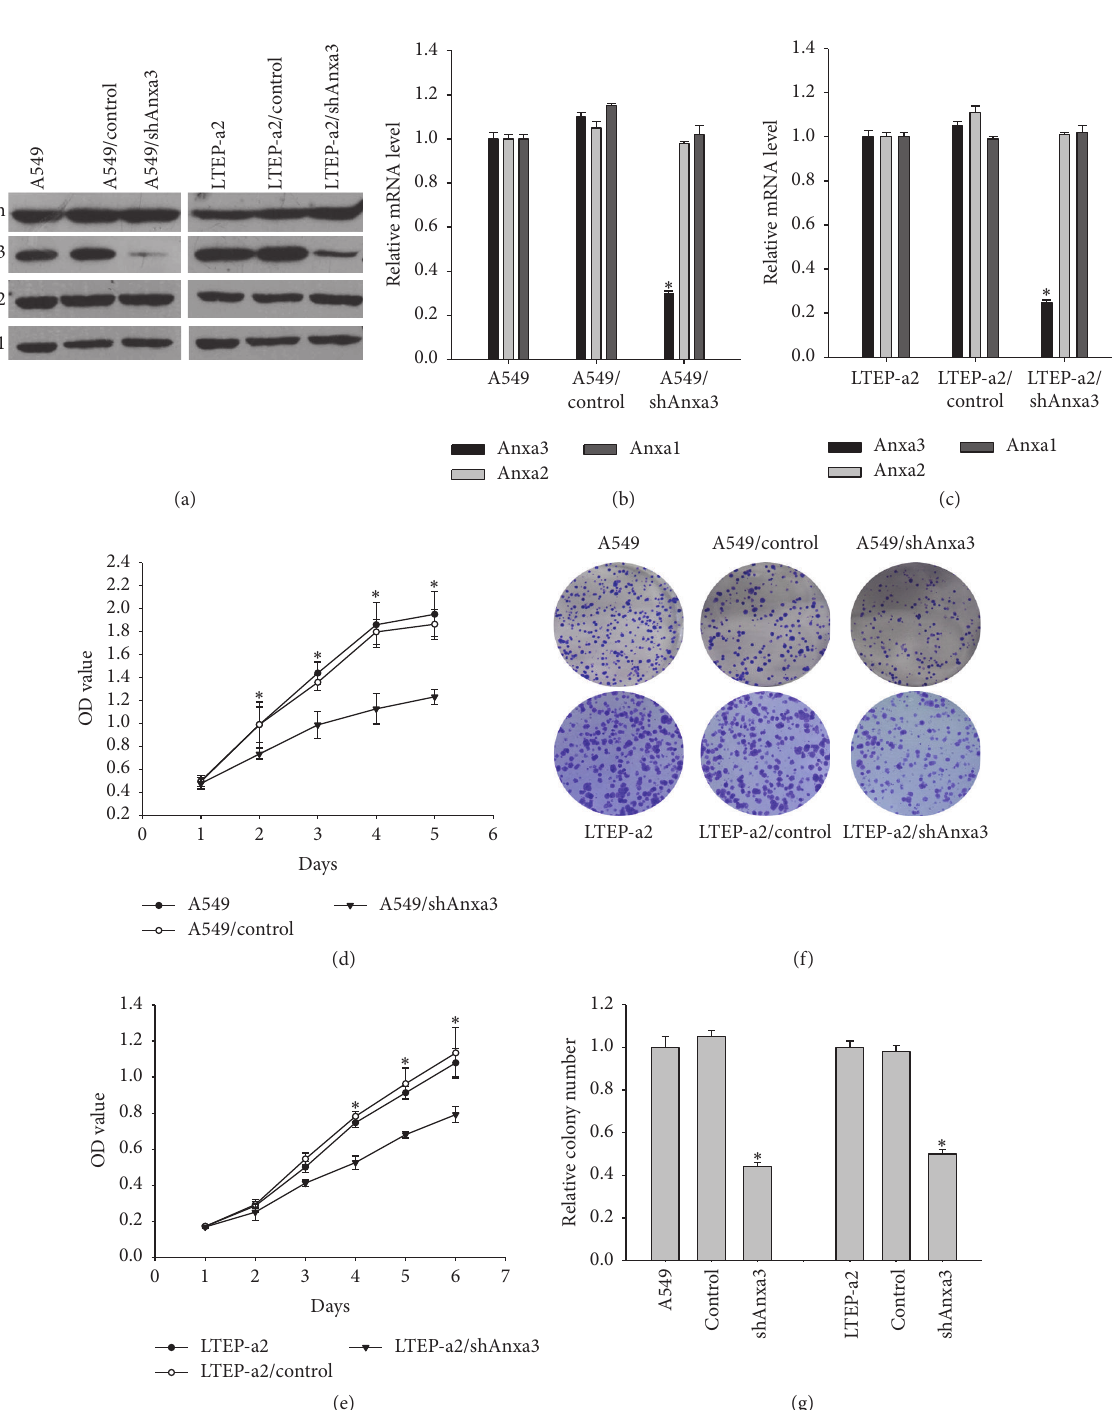
Figure 1: Detection of cell viability after Anxa3 downregulation. (a) Western blot and qPCR (b and c) showed Anxa3, Anxa2, and Anxa1 expression levels in stably transfected shAnxa3 or control shRNA cell lines. MTT assay (d, e) showed that cell viability decreased after Anxa3 downregulation. Colony formation assays (f) and (g) histograms of relative colony numbers indicated that the knockdown of Anxa3 expression significantly reduced colony formation by LADC cells. ∗ indicates 𝑝 < 0.05